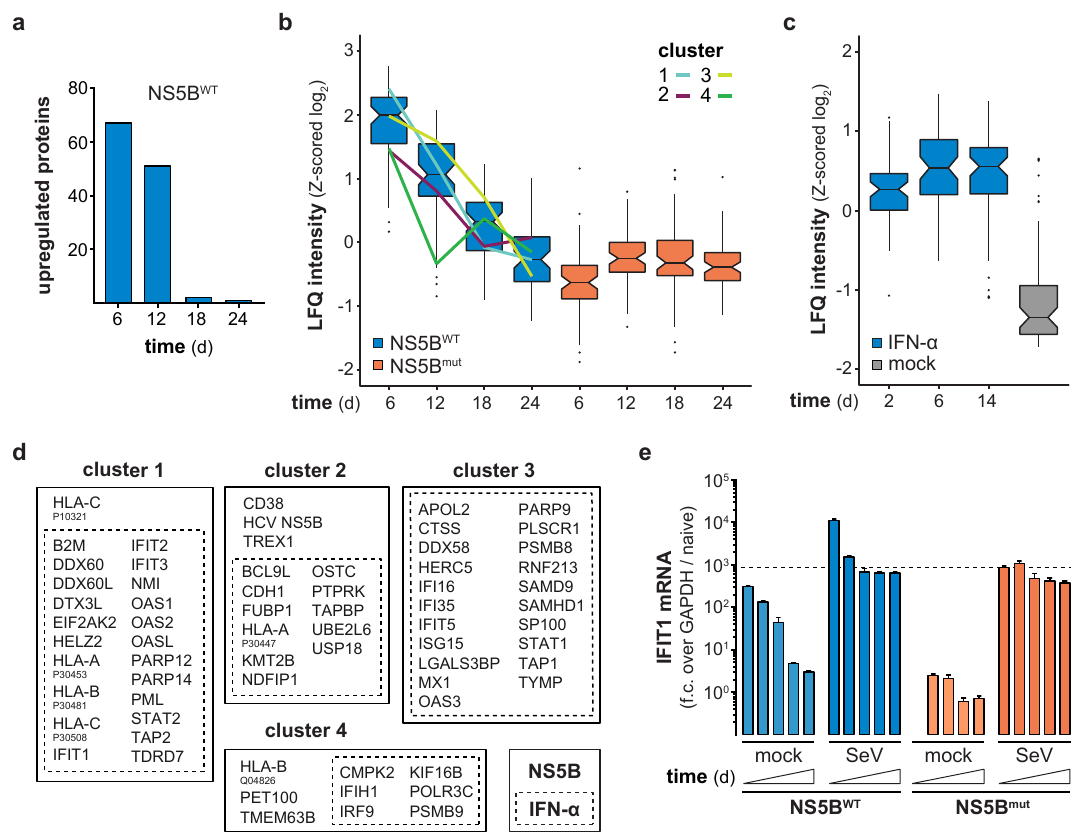
Figure 3. Time-resolved proteomics identifies di ff erentially regulated proteins in NS5B and IFN- α treated cells. ( a ) Number of significantly upregulated proteins (two-tailed Student’s t -test, S0 = 1, permutation-basedFDR < 0.01, n = 4technicalreplicates)attheindicateddayspostNS5B WT transduction as compared to NS5B mut . ( b , c ) Box and whisker plots (median, hinges: 1st and 3rd quartiles, whiskers: ± 1.5 × inter-quartile-range) of Z-scored median log 2 label-free quantification (LFQ) intensities of proteins, significantly upregulated at 6 days post NS5B WT transduction, tracked over time in NS5B WT and NS5B mut transduced ( b ) or 8.25 ng / mL IFN- α and mock treated ( c ) cells. Hierarchical clustering (Euclidean distances, Ward agglomeration method; Figure S3) of Z-scored log 2 LFQ intensities of these proteins in NS5B WT transduced cells across time points identified four main clusters of di ff erentially upregulated proteins (cluster 1, light blue; cluster 2, purple; cluster 3, yellow; cluster 4, green). ( d ) Intersection of NS5B WT (solid box) upregulated proteins at day 6 post transduction with data of IFN- α (dashed box) treated cells. Upregulated proteins were assigned to each of the identified clusters. ( e ) IFIT1 mRNA levels in A549 cells non-infected or infected with Sendai Virus (SeV) at 7, 11, 15, 19, and 23 days after NS5B WT or NS5B mut transduction. IFIT1 fold change (f.c., mean + s.d. of n = 3 technical replicates) over GAPDH and naïve cells was calculated. The dashed line indicates IFIT1 mRNA levels in SeV infected cells 7 days after NS5B mut